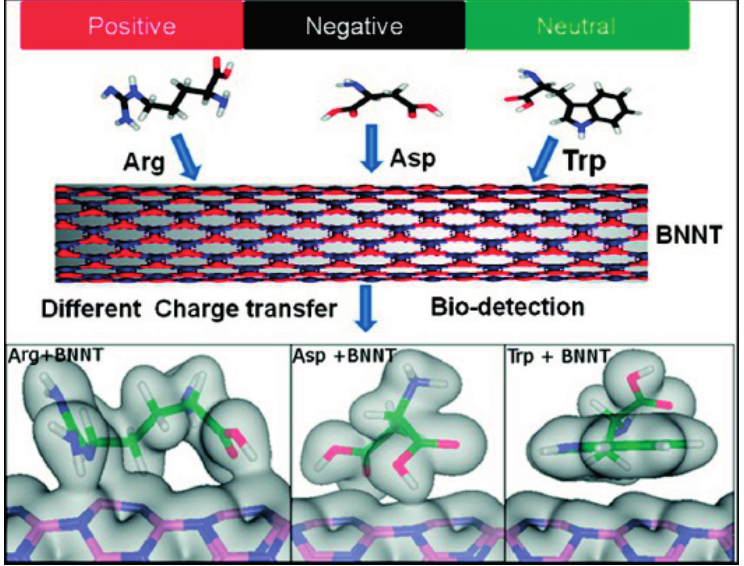
Figure 7. Non-covalent functionalization of BNNT with polar and non-polar amino acids. Trp (non-poar), Asp (polar), and Arg (polar) stand for tryptophane, asparatic, and argenine, respectively. The upper panel shows the charge transfer between the BNNT and amino acids, and the lower panel represents the iso-surface charge density of amino acids functionalized BNNT system. Reprinted with permission from [138]; © 2008 American Chemical